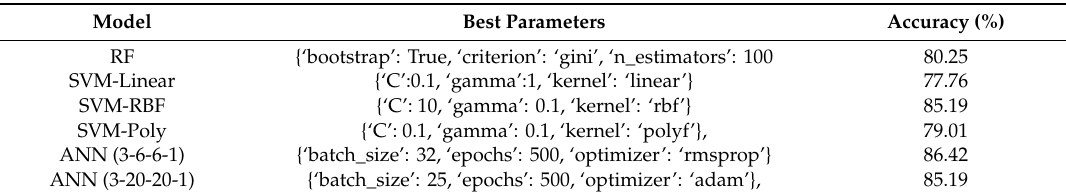
Table 16. The accuracies achieved by the ML models after performing grid search with 10-Fold